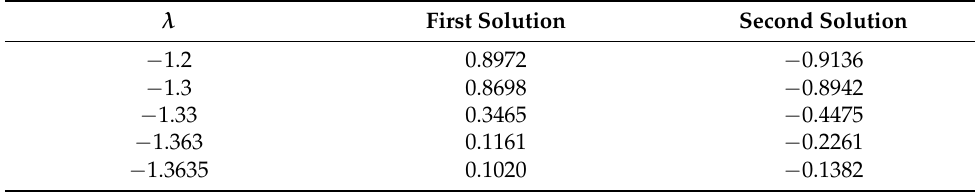
Table 6. The smallest eigenvalues ω 1 with assorted λ